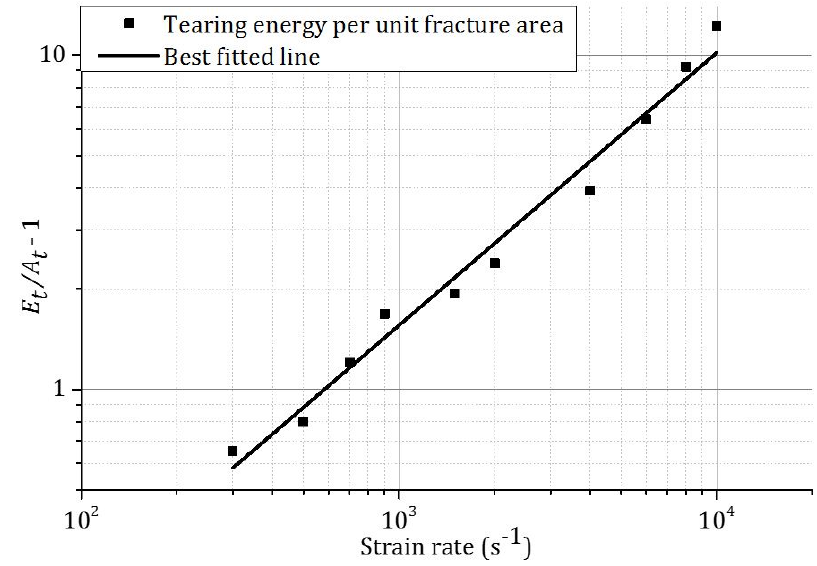
Figure 12. The dependency of tearing energy per unit fracture area of honeycombs and strain rate.